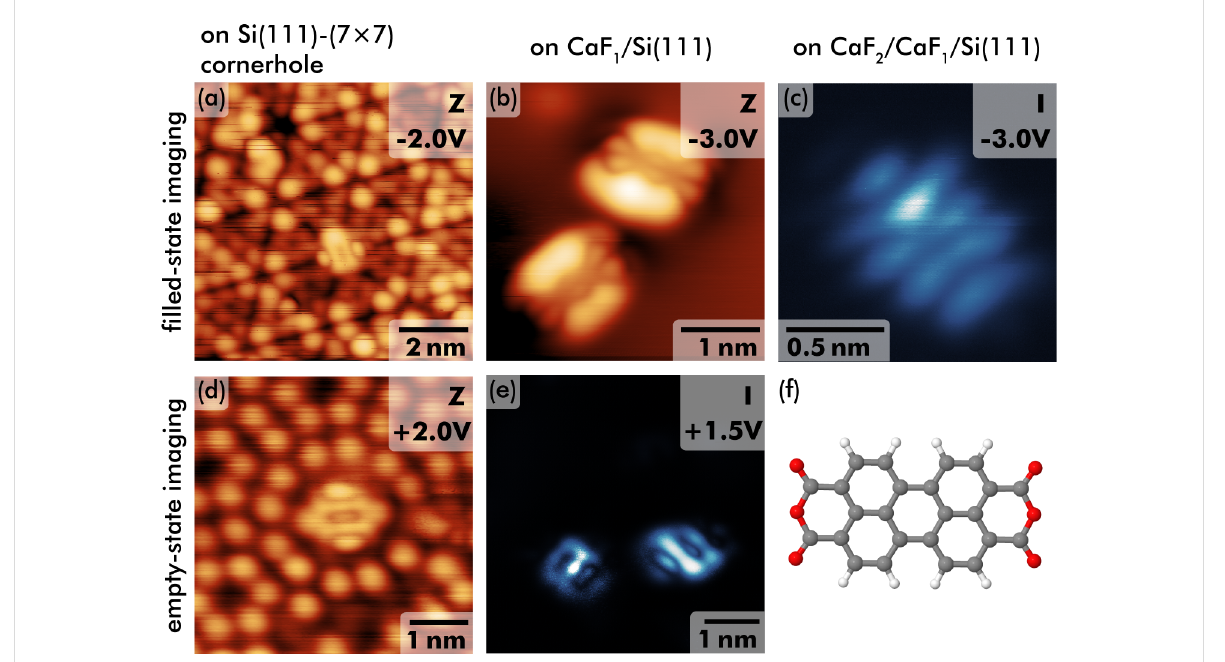
Figure 2: STM images of individual PTCDA molecules on different surface areas. Imaging of PTCDA on a Si(111)-(7 × 7) cornerhole position at (a) negative and (d) positive sample bias (sample bias indicated in the upper right corner). (b) Topography-mode image at negative bias and (e) con- stant-height mode imaging at positive bias of PTCDA on a CaF 1 /Si(111) surface area. (c) Example of imaging PTCDA on a CaF 2 /CaF 1 /Si(111) multi- layer in constant-height mode. (f) Model drawing of a single PTCDA molecule (black: carbon, white: hydrogen, red: oxygen